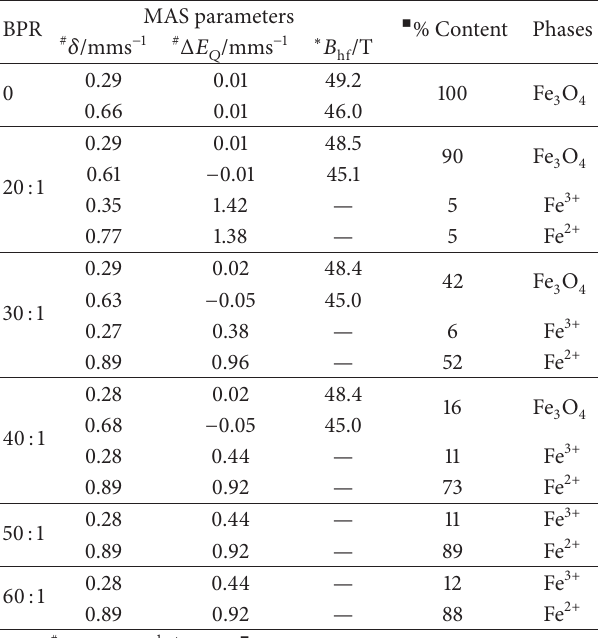
Table 2: MAS parameters of the ball-milled magnetite and graphite mixtures (1:3 mole ratio) at different ball to powder ratios (BPR), while rotational speed and milling periods were kept constant at 400 rpm and 20 hours,